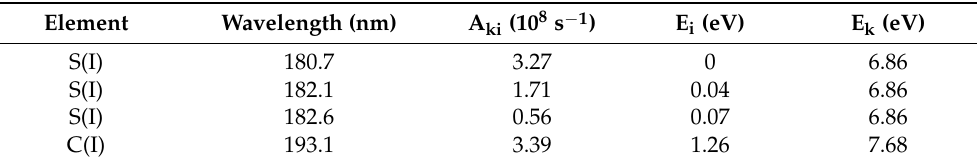
Table 2. Characteristics (i.e., wavelength, transition probability (A ki ) and lower and upper energy